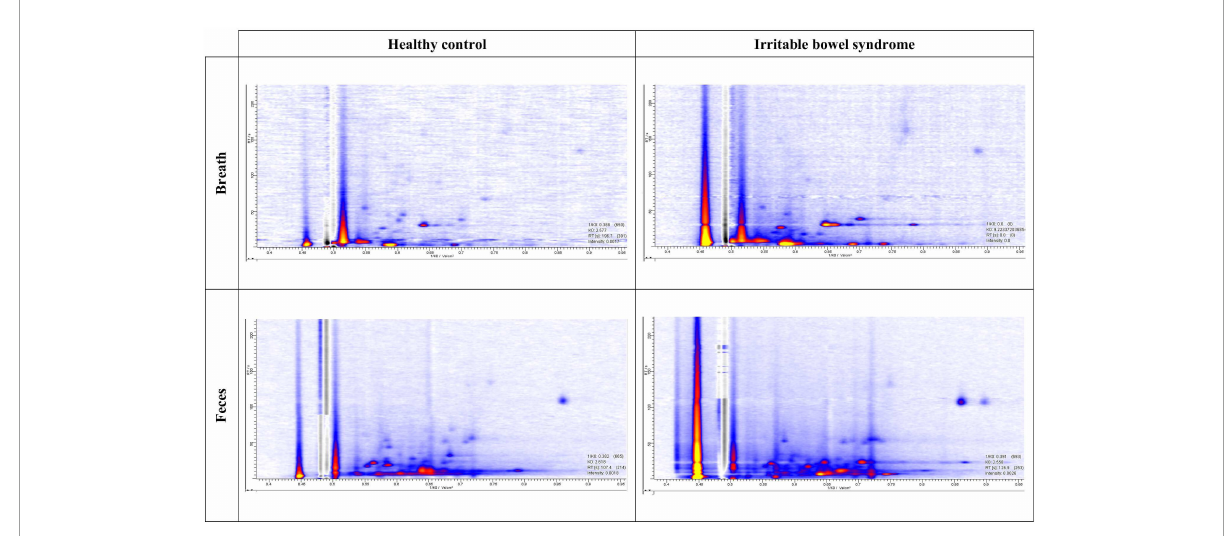
FIGURE1 Example of chromatograms. Intensities are presented with the help of a color code from low intensity (blue) to high intensity (yellow).